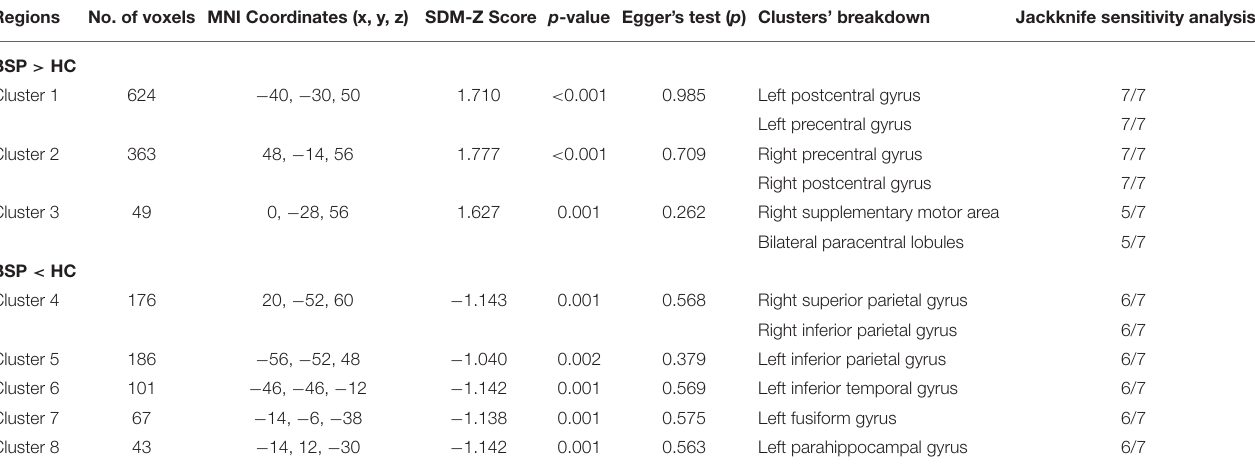
TABLE 3 | Clusters of gray matter structural alterations in patients with idiopathic blepharospasm compared with healthy controls.